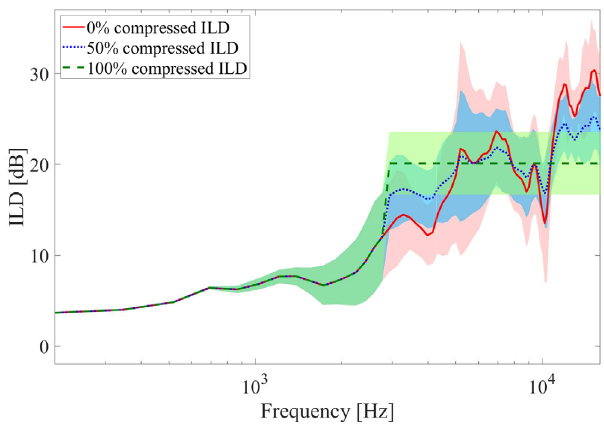
Figure 3. Median values of externalization ratings and mapped results for smoothed spectral magnitude in the HRTF of the ipsilateral ear while maintaining the original ILD. All other conventions are as in Figure 2.